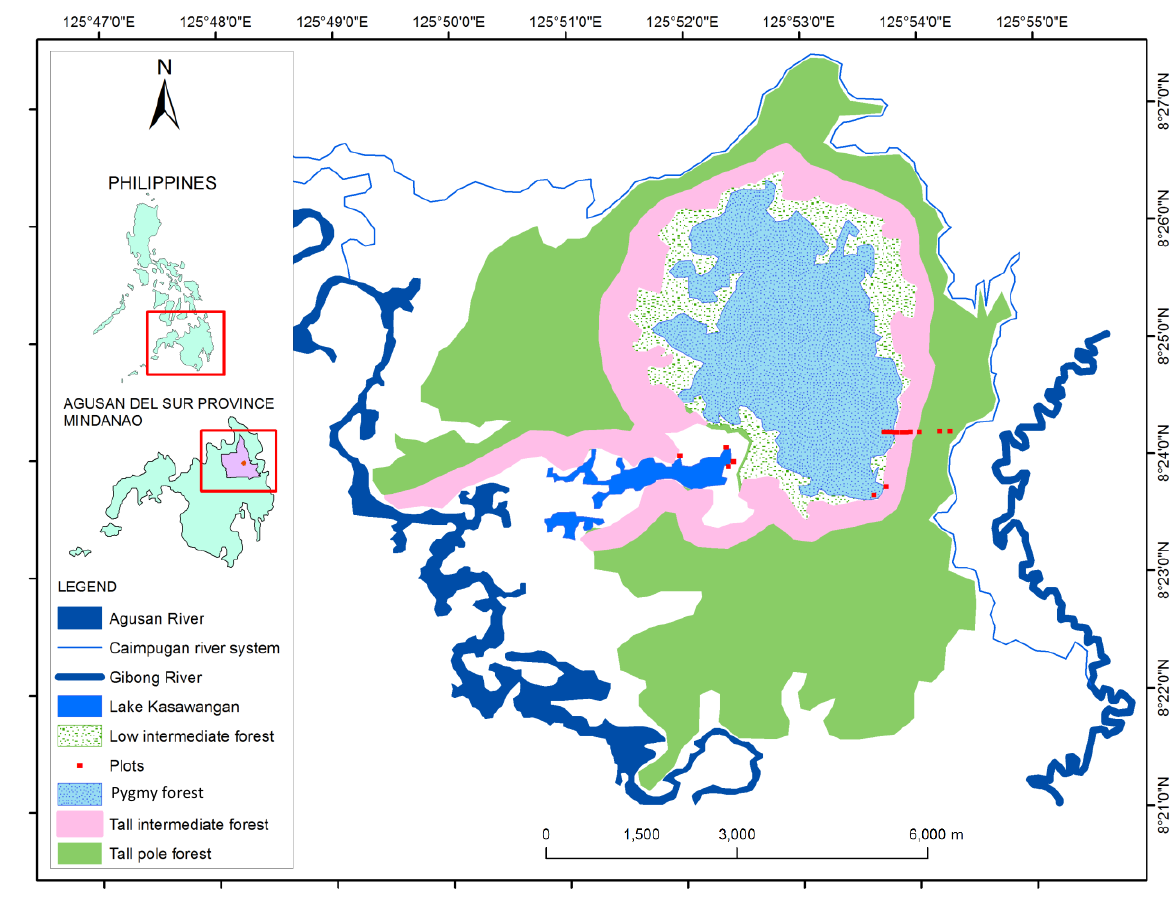
Figure 1. Map of the Caimpugan peat swamp forest, Agusan del Sur Province (lower inset) on Mindanao Island, Philippines (upper inset), showing the distribution of sampling